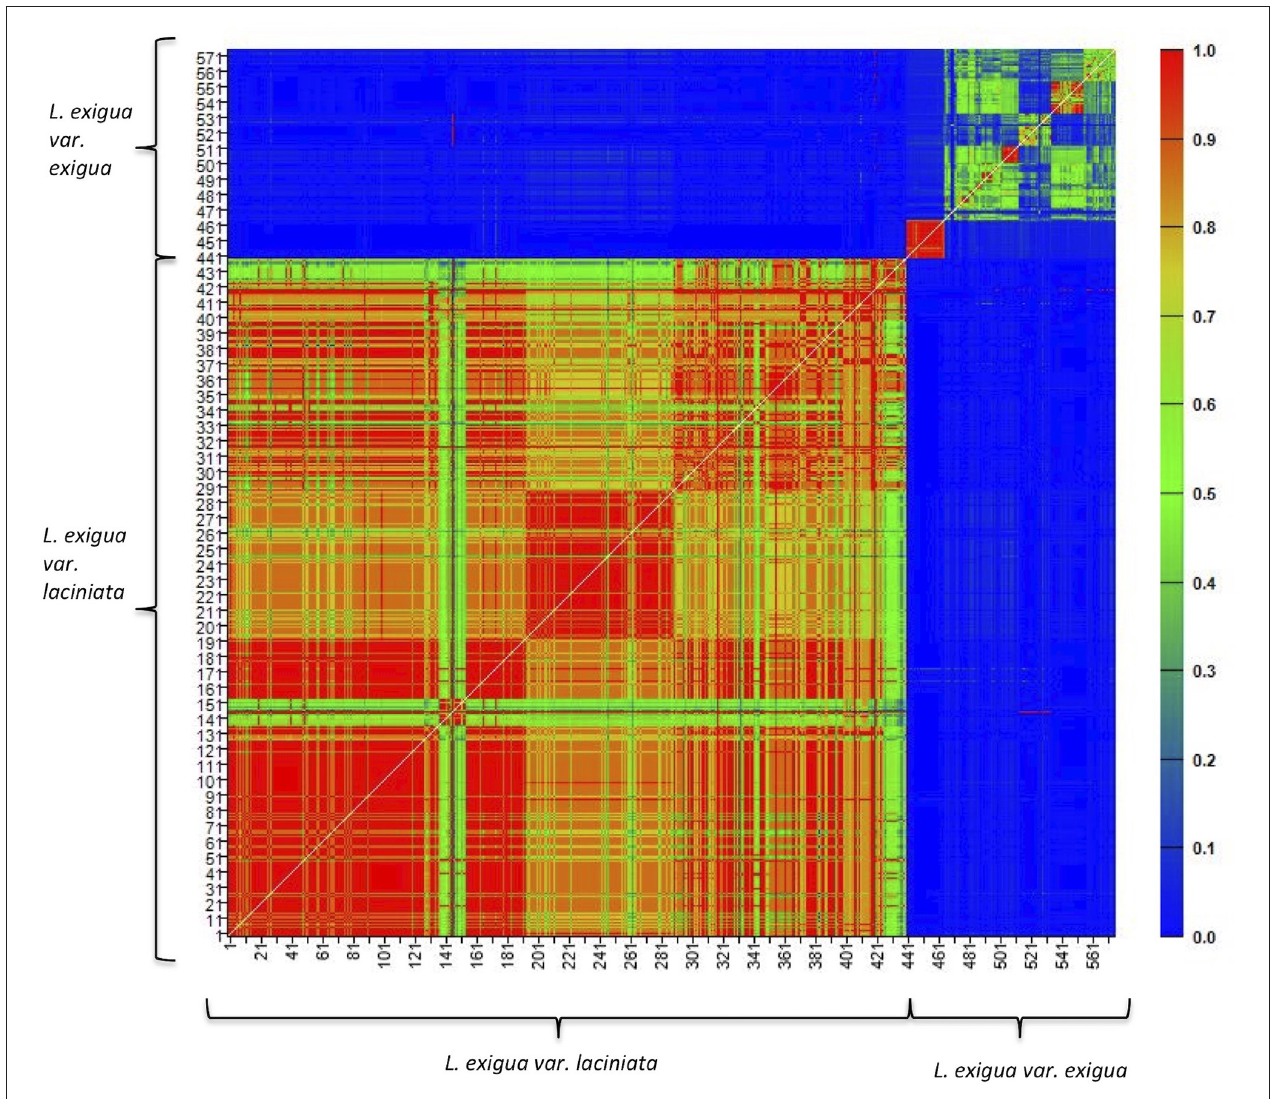
FIGURE 2 | Heatmap of pairwise relatedness between all individuals of Leavenworthia exigua sampled in this study. Warm values indicate high levels of pairwise relatedness and cool values indicate lower relatedness. Individuals 1–440 were identified as L. exigua var. laciniata and 441–576 indicate individuals of L. exigua var. exigua